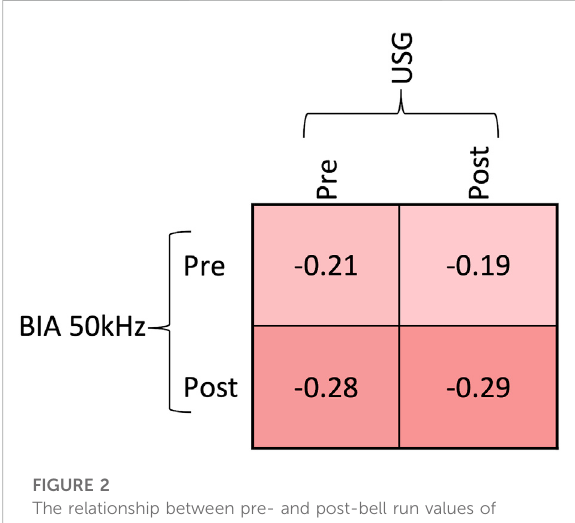
FIGURE 2 The relationship between pre- and post-bell run values of USG and BIA at 50 kHz analyzed by Spearman correlation coef fi cients. All coef fi cients were statistically signi fi cant ( p < 0,02), implying that there was a negative correlation between USG and